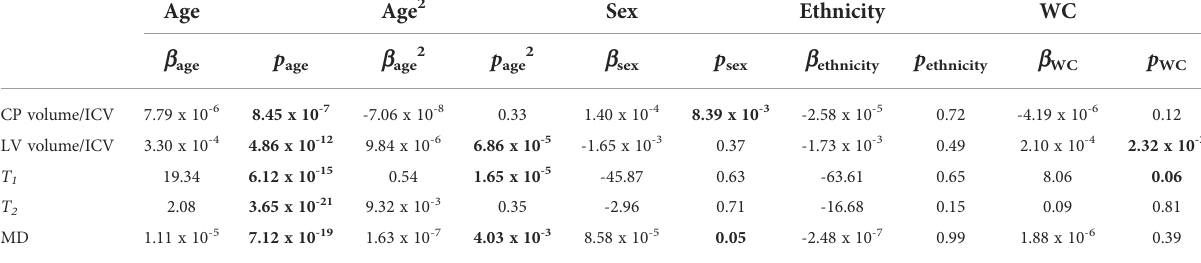
TABLE 3 Slope, b , and signi fi cance, p , of the regression terms incorporated in the multiple linear regression given by: Lateral ventricle (LV) volume/intracranial volume (ICV),